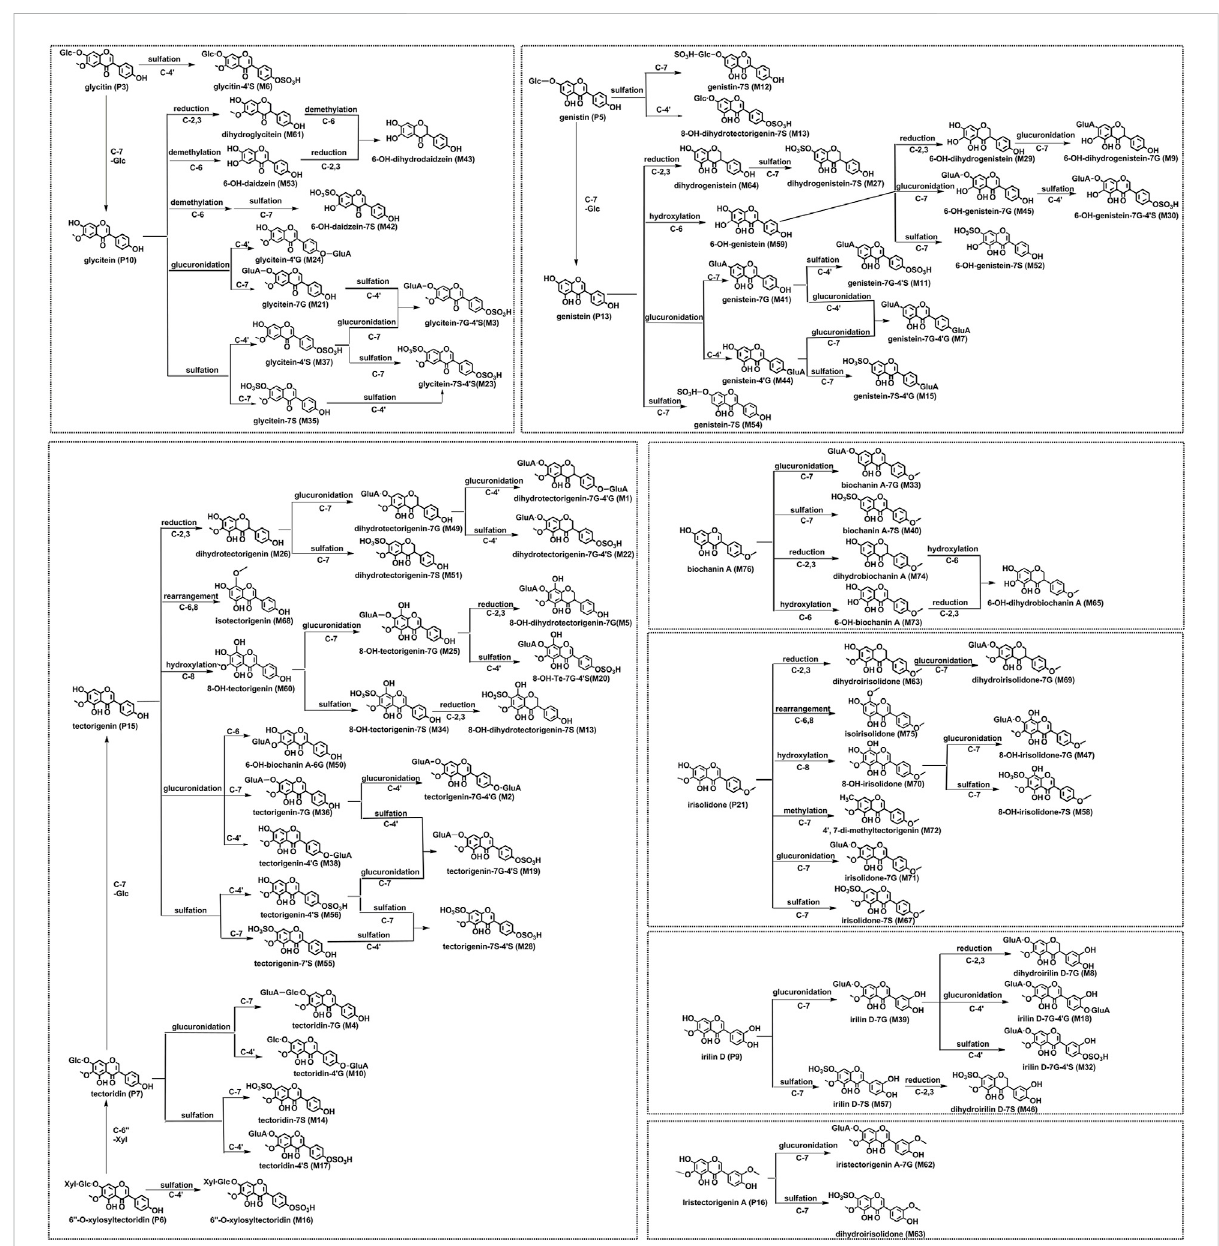
from PF in vivo was outlined, as shown in Figure 2. The results indicated that irilin D (P9), glycitein (P10), genistein (P13), tectorigenin (P15), iristectorigenin A (P16), and irisolidone (P21), which were the aglycone of fl avonoids constituent in PF extracts, were the key prototype components in the metabolic